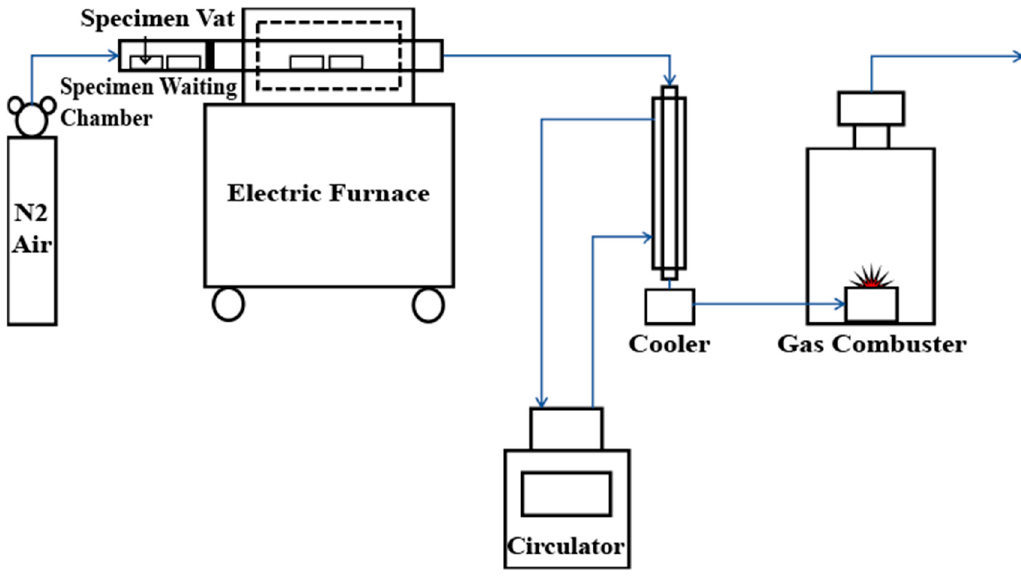
Figure 1. Schematic of the pyrolysis reactor used in this study.